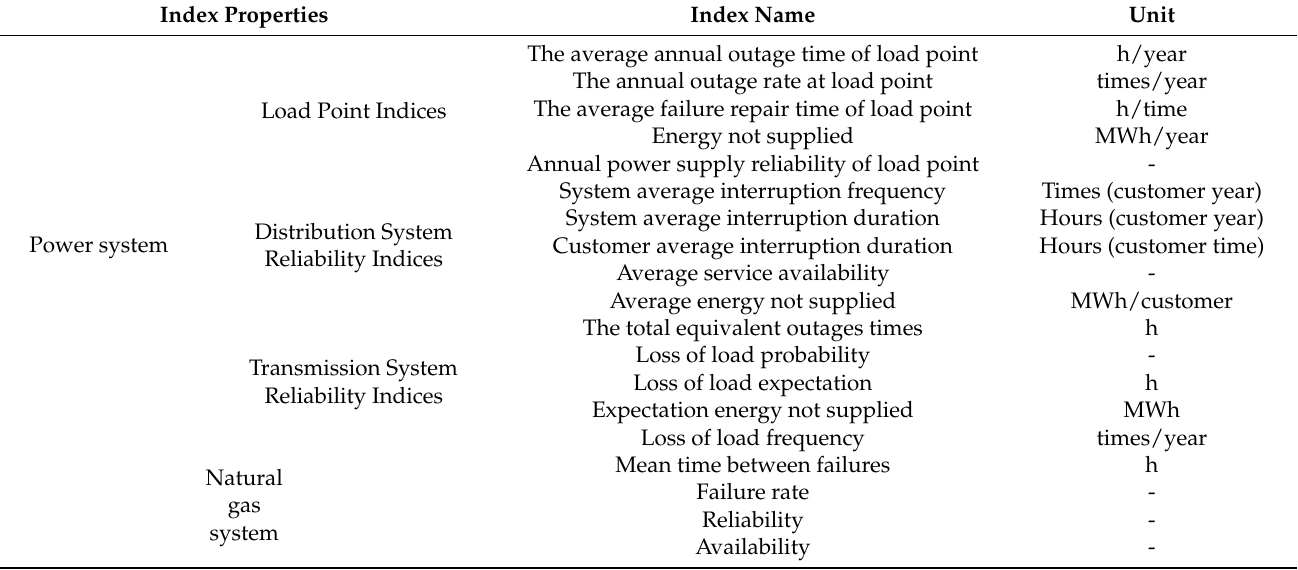
Table 1. Summary of reliability indices in the